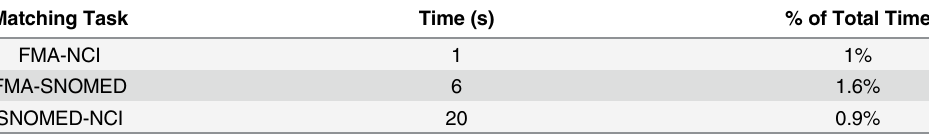
Table 3. Core fragments computation times for each OAEI large biomedical track matching problems.